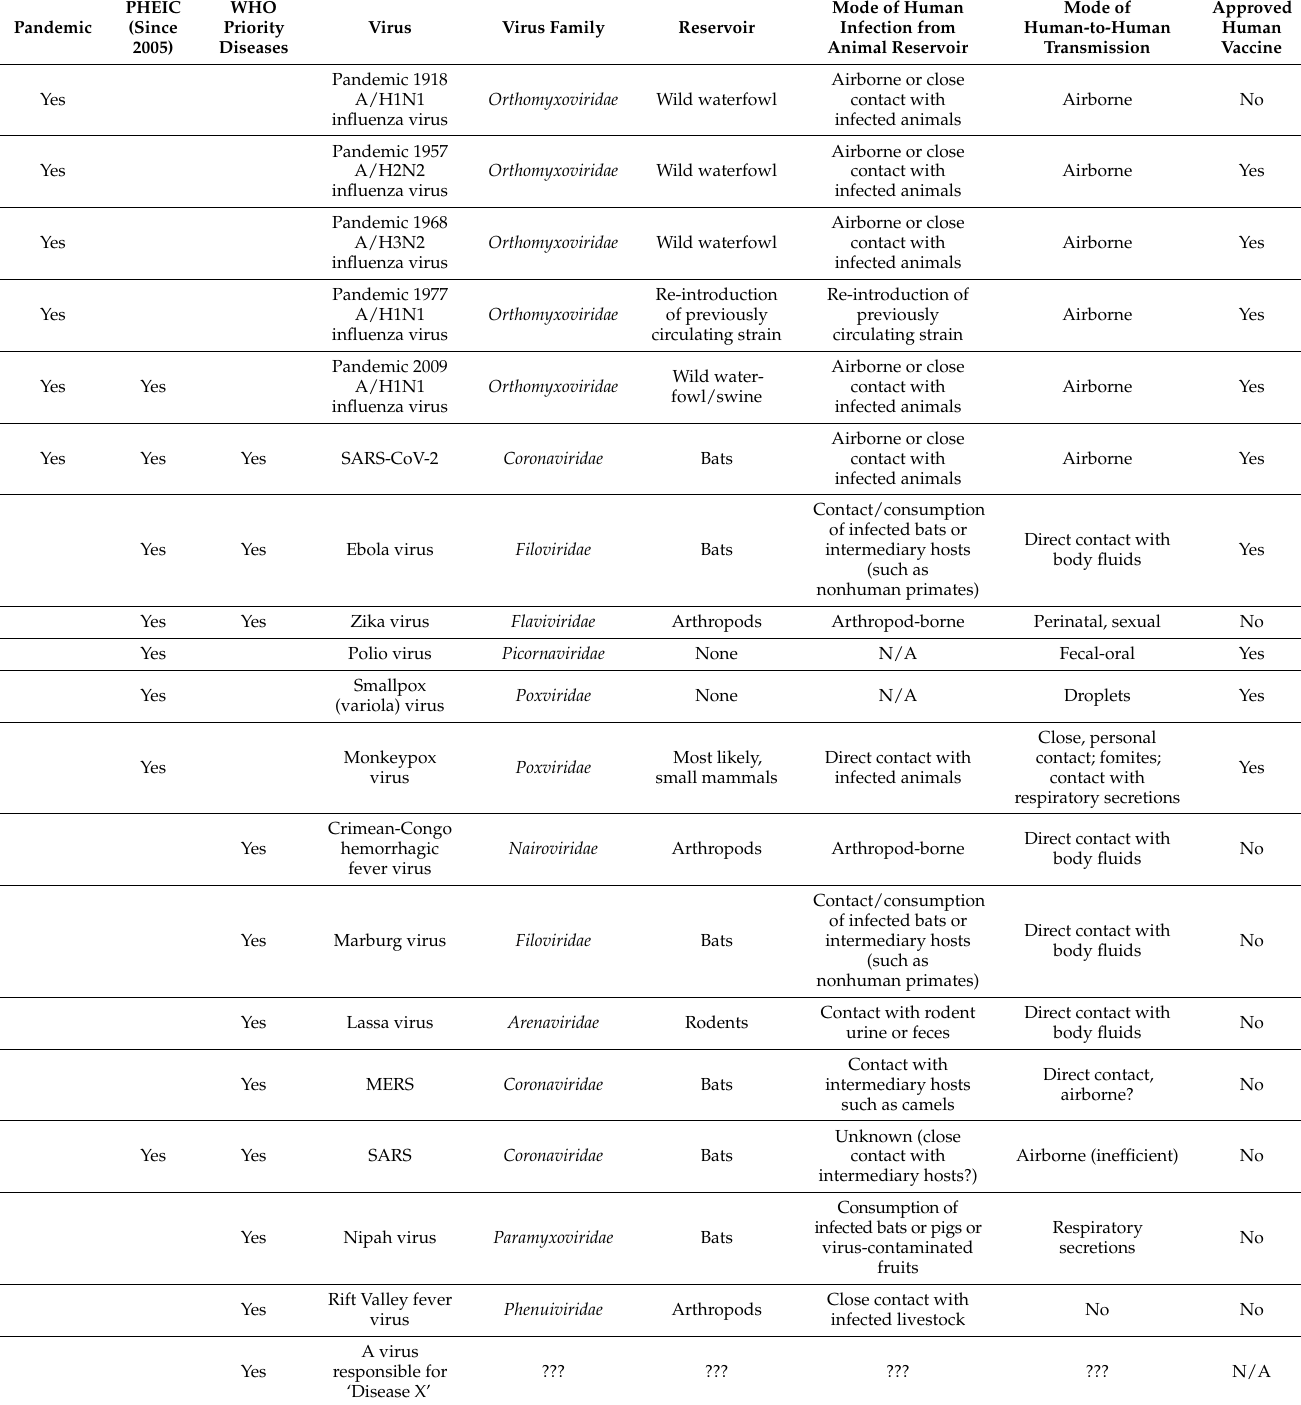
Table 1. Overview of pandemic viruses, PHEIC agents, and viruses causing WHO priority